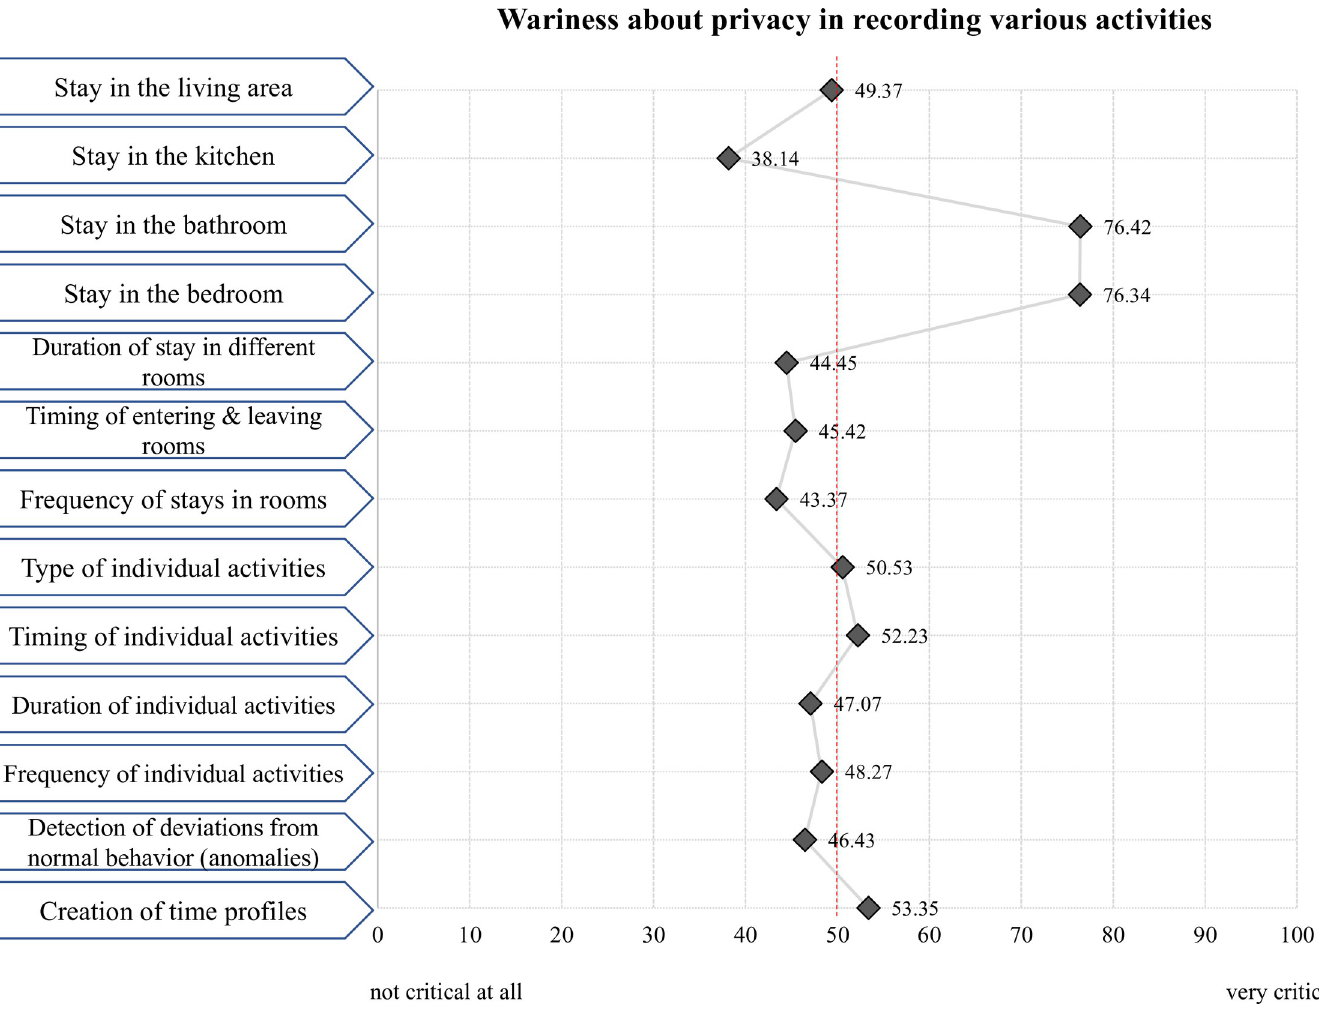
Fig 8. Wariness about privacy issues when using sensor-based